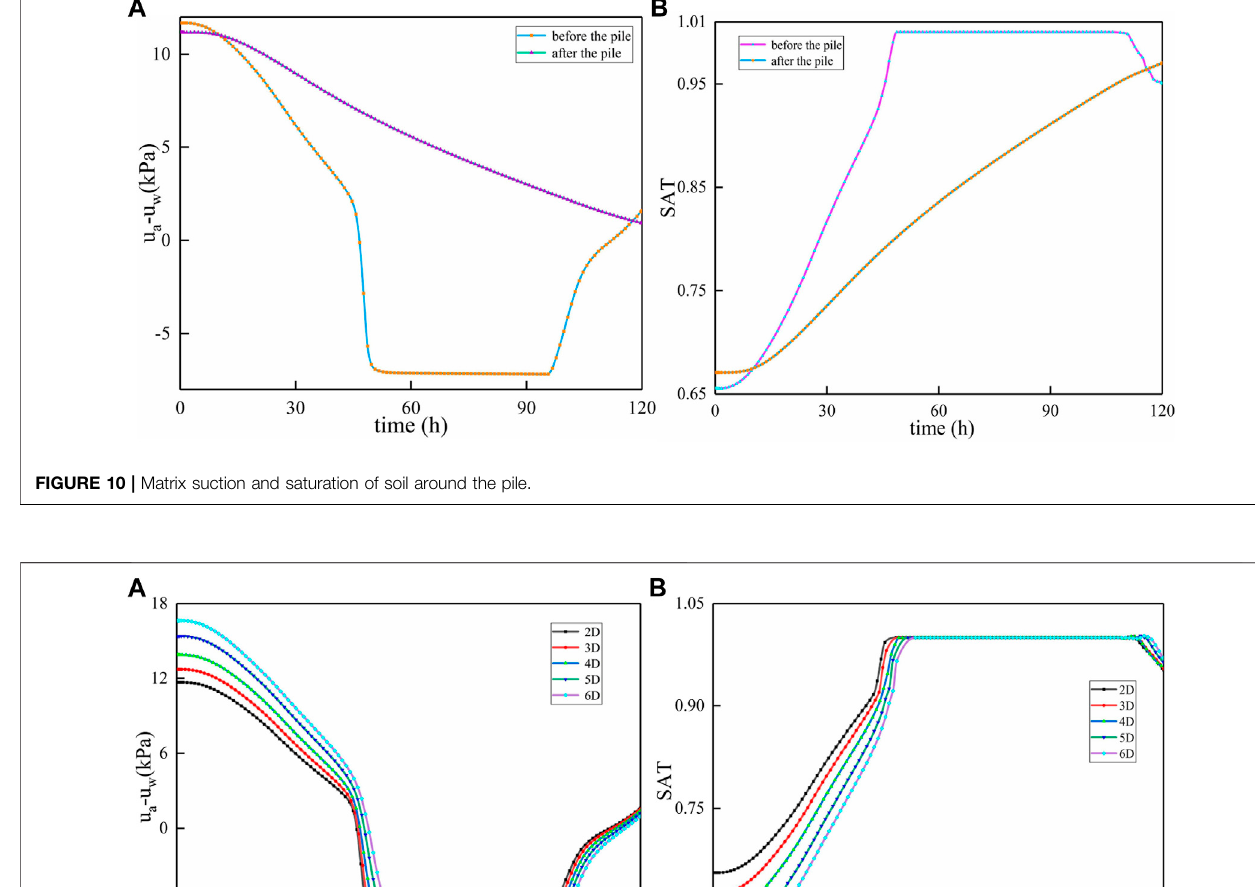
Frontiers in Earth Science |